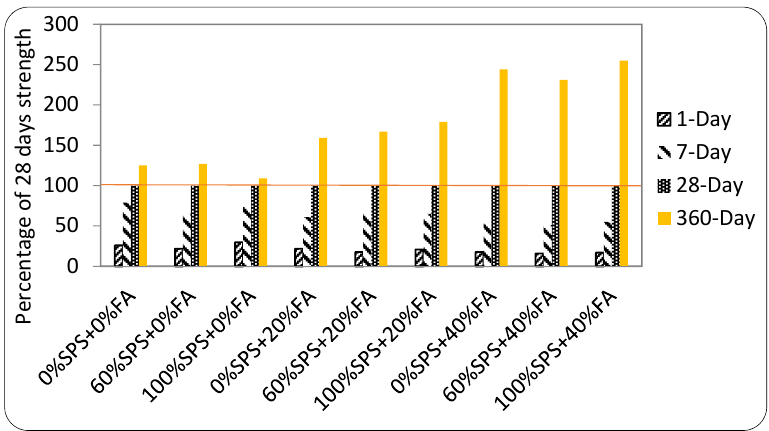
Figure 7. Percentage of 28 ‐ day strength development with age.